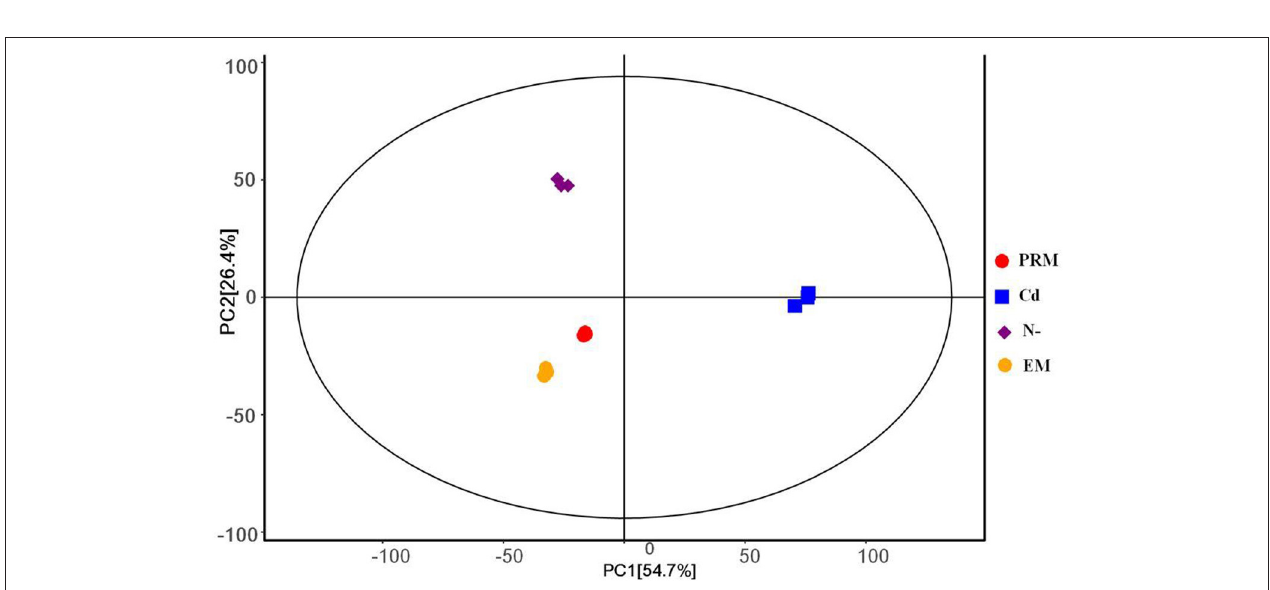
FIGURE 1 | PCA score plot under different treatment groups based on metabolites, each with 3 biological replicates. PRM, paromomycin; Cd, CdCl 2 addition; N–, nitrogen deprivation; EM,